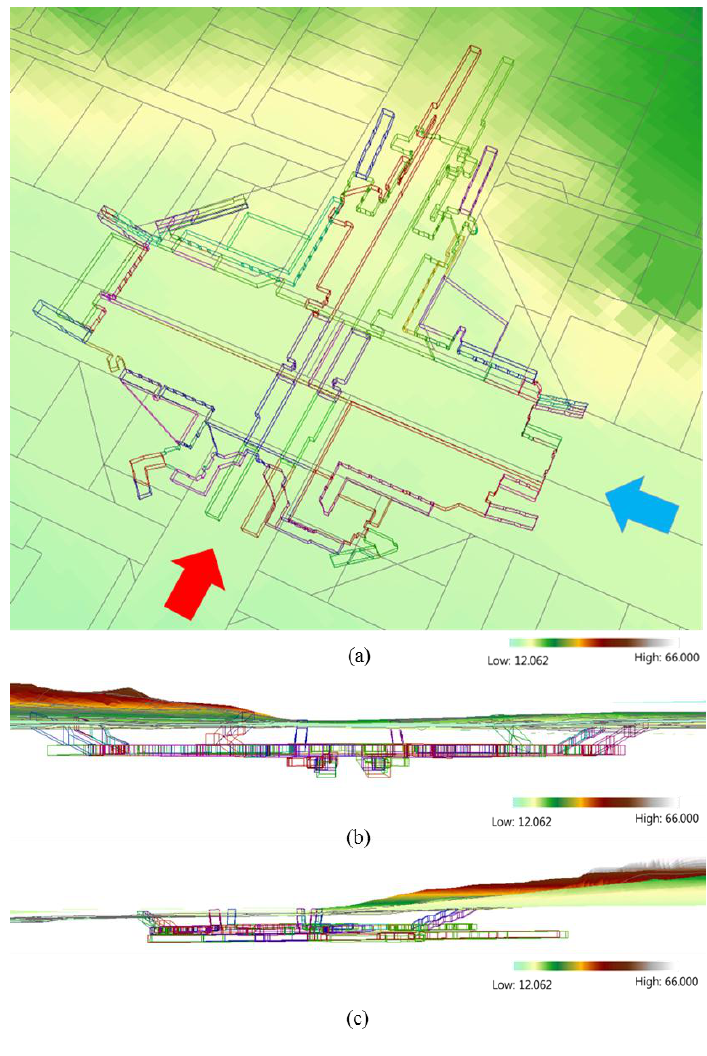
Figure 12. 3D surface and 3D underground cadastral map (unit: meters): ( a ) top view of 3D underground parcel with transparency effect; ( b ) Front view of 3D underground property (direction of red arrow on Figure 12a); and ( c ) Side view of 3D underground property (direction of blue arrow on Figure 12a).